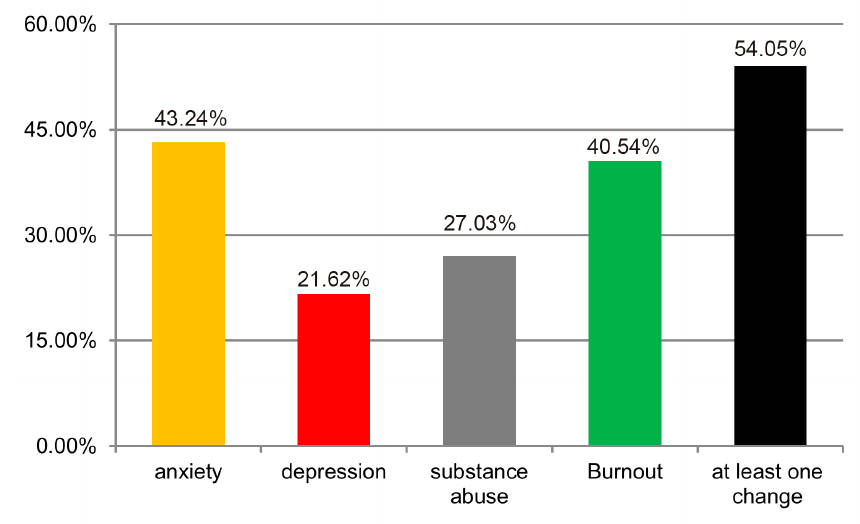
Fig. 1 - Prevalence of mental health disorders in the population